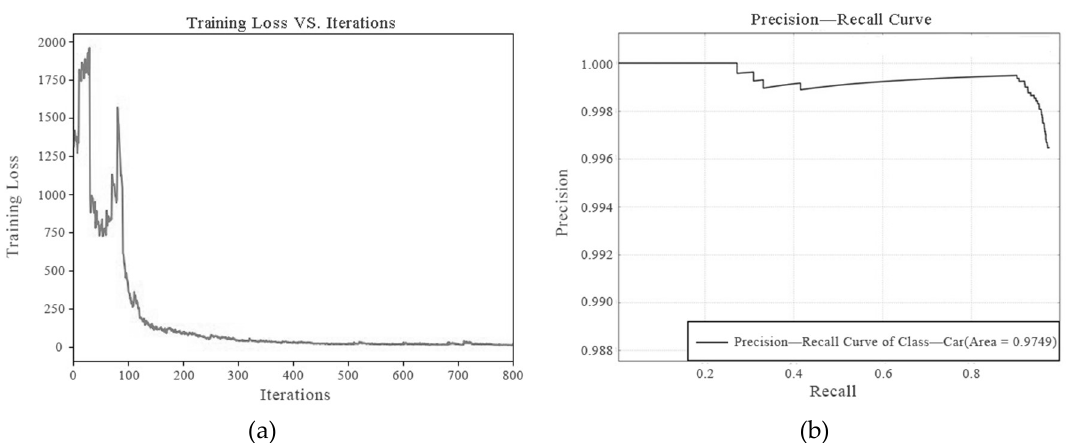
Figure 10. The training and test results of the improved YOLOv3: ( a ) The loss curve for network training; ( b ) the test PR curve for the network.